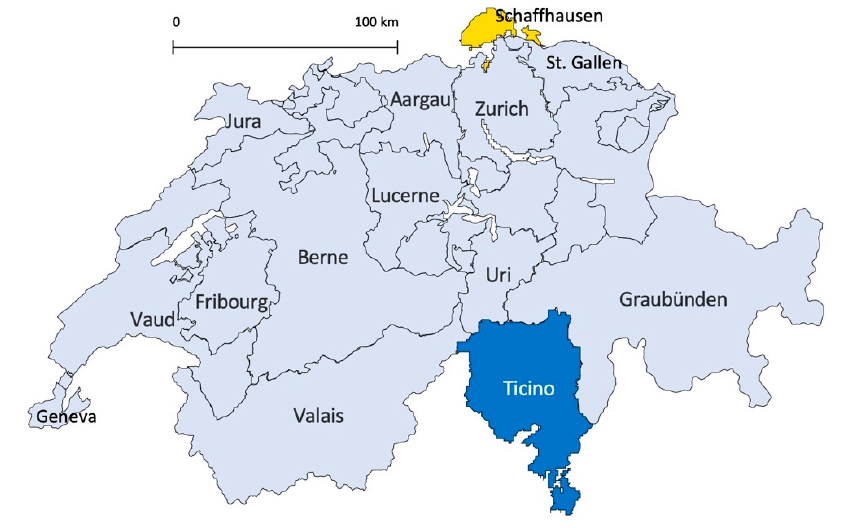
Figure 1. Map of Switzerland showing the cantons and the sampling areas. Wild boars belonging to group 1 originated from the canton Schaffhausen (indicated in yellow). Animals from group 2 were from the canton Ticino (shown in blue).